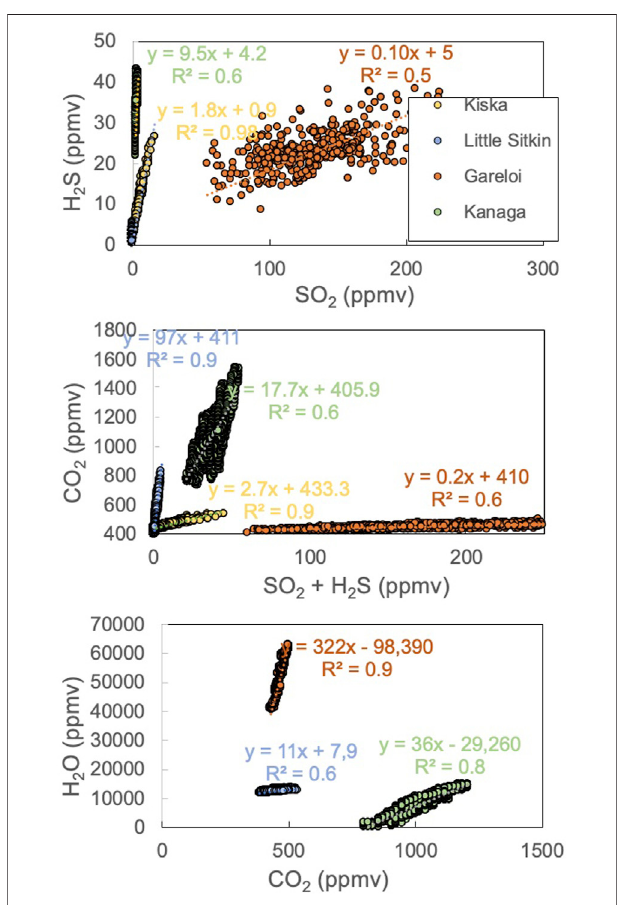
FIGURE 3 | Plume and fumarole gas compositions measured by